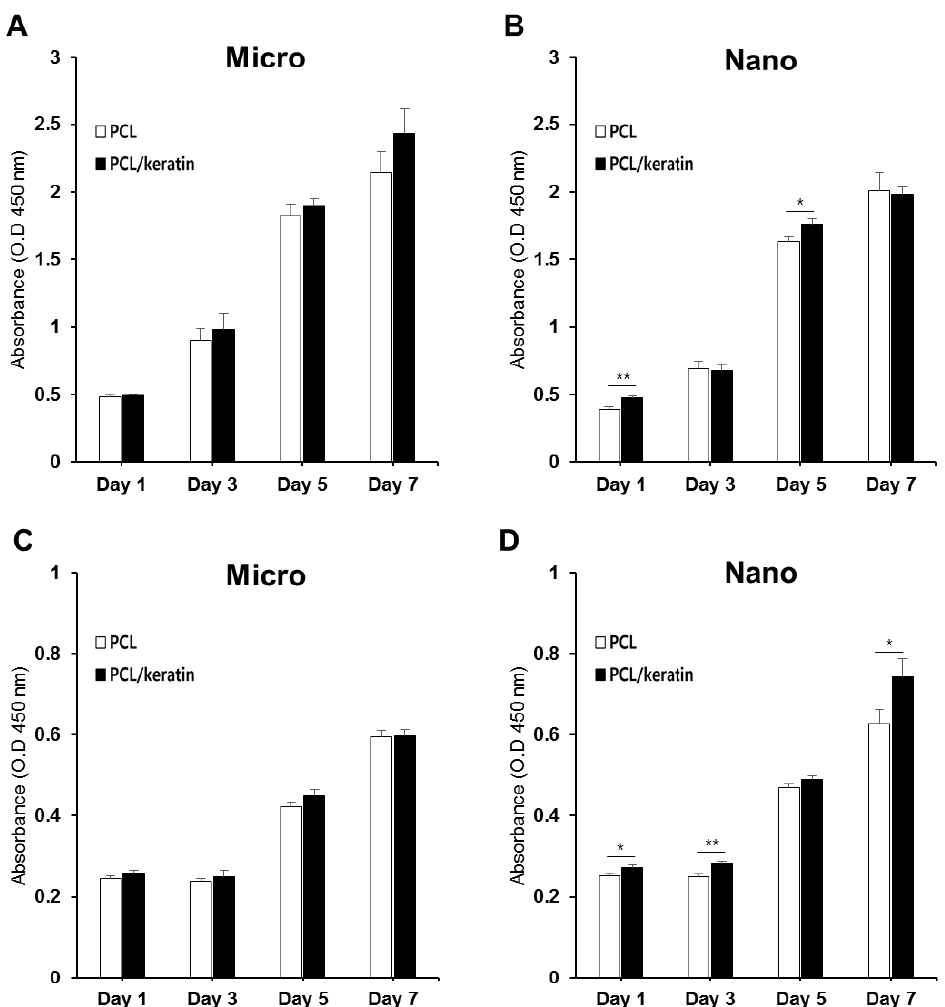
Figure 4. Comparison of the cell proliferation results. ( A ) NHDFs on microfibers, ( B ) NHDFs with nanofibers, ( C ) HaCaTs on microfibers, and ( D ) HaCaTs on nanofibers (* p < 0.05, ** p < 0.01).